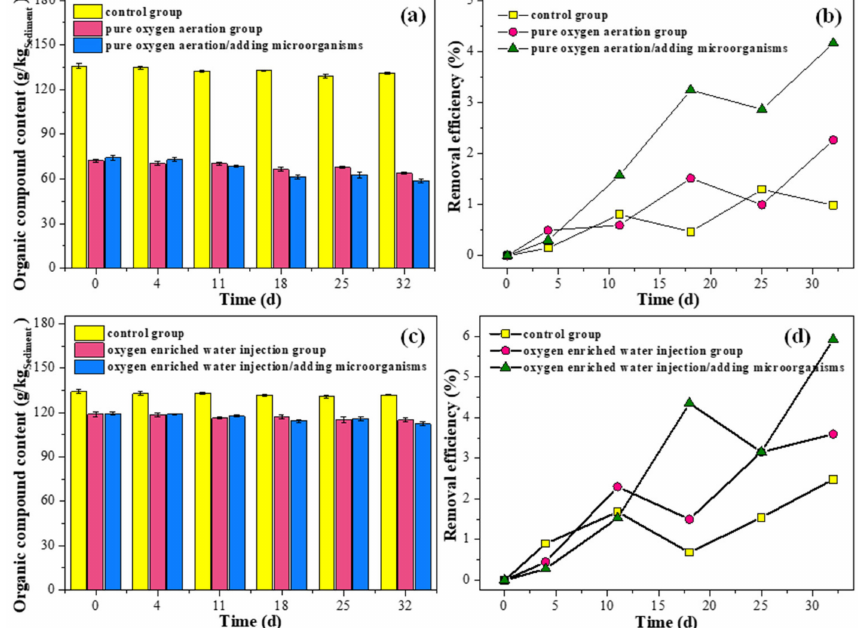
Figure 8. The changes of the organic compound content in the sediment during ( a ) pure oxygen aeration treatment and ( c ) oxygen enriched water injection treatment after adding microorganisms; removal e ffi ciencies of the organic compounds during ( b ) pure oxygen aeration treatment and ( d ) oxygen enriched water injection treatment after adding